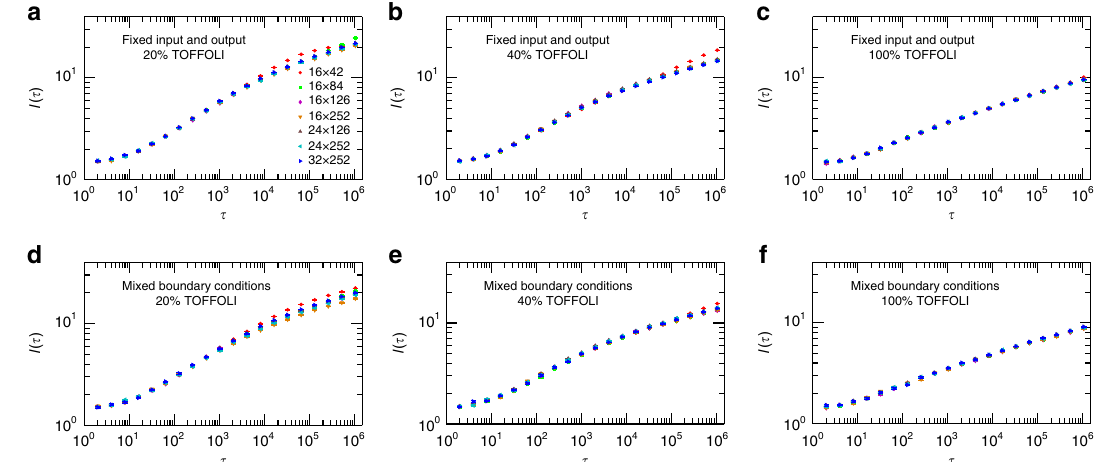
Figure 4 | Scaling of the dynamical correlation length ‘ ð s Þ . For all sizes and cases, 2,000 realizations of the boundary states were used. The data-point code used in a applies to all other panels. When not visible, the error bars are smaller than the size of the data points. ( a – c ) Fixed input and output; ( d – f ) mixed boundary conditions; ( a , d ) 20% TOFFOLI; ( b , e ) 40% TOFFOLI; and ( c , f ) 100% TOFFOLI. For systems with the smallest depth W studied, 16 (cid:4) 42, and for circuits with few TOFFOLI gates (20%) and fixed-input and output boundary conditions, ‘ ð t Þ tends to saturate, indicating that complete solutions have been reached. Notice that the functional form of the scaling does not depend on the boundary conditions, and depends solely on the concentration of TOFFOLI